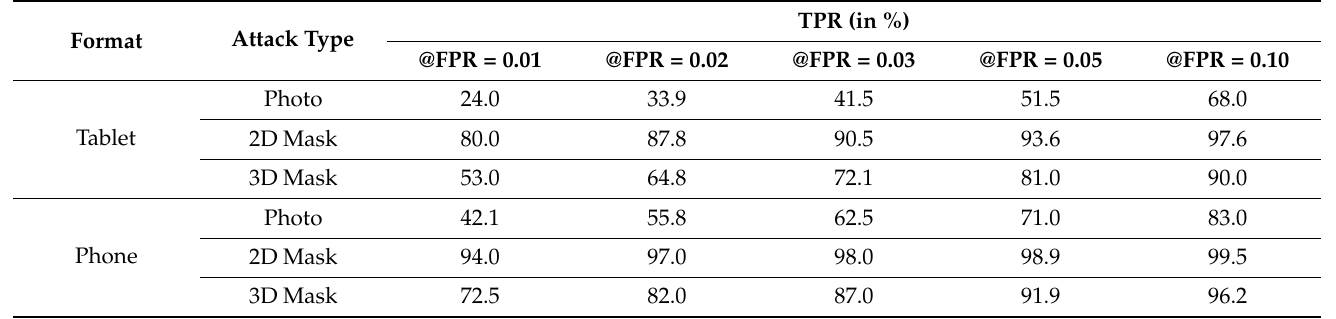
Figure 6. ROC curves for the photo, 2D mask and 3D mask. Stimulus trajectory: Curves . Form factors: ( a ) tablet format; and ( b ) phone format. Table 3. TPR at various FPR settings (trajectory: Curves , duration: 5 s).